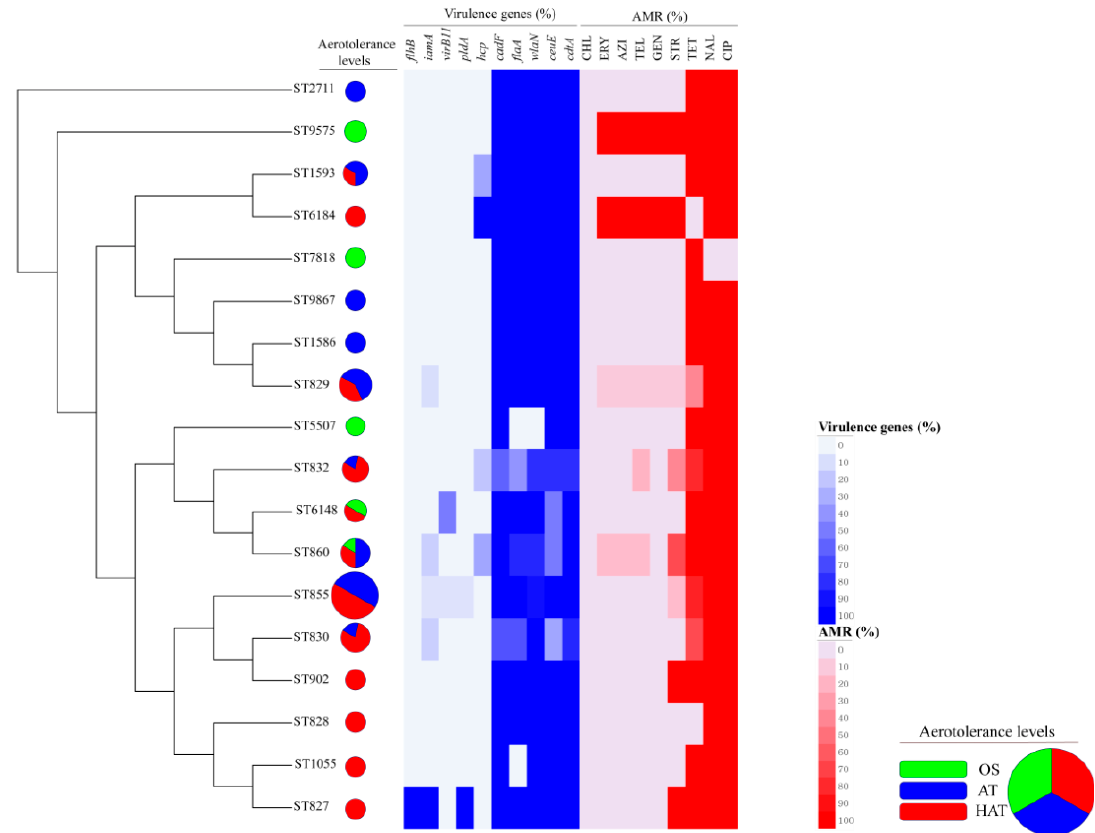
Figure 2. Clonal distribution of C. coli isolates by multi-locus sequence typing (MLST) sequence types (STs). The unweighted-pair group method with arithmetic mean (UPGMA) dendrogram was generated using MLST STs in 56 C. coli isolates based on allele numbers of seven MLST housekeeping genes. The image represents the distribution of aerotolerance levels, the proportion of 10 virulence genes, and antimicrobial resistance (AMR) of C. coli belonging to each MLST ST. The pie chart presents the distribution of aerotolerance levels (green, OS; blue, AT; red, HAT) among C. coli isolates. OS, oxygen-sensitive; AT, aerotolerant; HAT, hyper-aerotolerant.